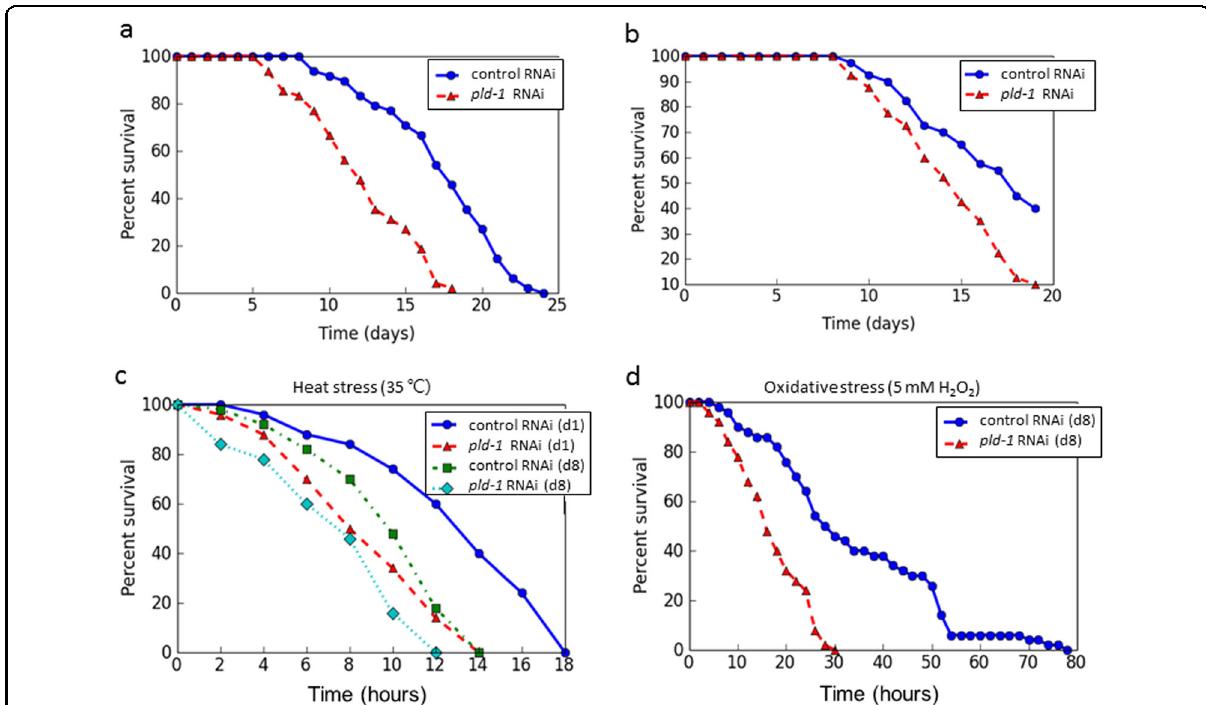
Fig. 2 Pld-1 RNAi decreases lifespan and stress resistance in nematodes. a , b Effect of pld-1 RNAi on the lifespan of nematodes. a Age- synchronized L4 larvae were fed on control RNAi or pld-1 RNAi plates under standard conditions ( n = 50 per condition). b Lifespan assays using nematodes fed with pld-1 RNAi only during adulthood to exclude the effect of pld-1 knockdown on development. Age-synchronized L4 larvae were fed on control RNAi or pld-1 RNAi plates for 1 day ( n = 50 per condition). c , d Effect of pld-1 RNAi on stress resistance in nematodes. c Survival curves of nematodes fed with control or pld-1 RNAi at 35 °C. Nematodes at day 1 (d1) or 8 (d8) of adulthood were scored every 2 h for viability ( n = 50 per condition). d Survival curves of nematodes fed with control or pld-1 RNAi after exposure to 5 mM H 2 O 2 for 5 h. Nematodes at day 8 (d8) of adulthood were scored every 4 h for viability ( n = 50 per condition). Viability was scored as movement away from pick touch at the indicated days or hours. Representative data from three independent RNAi experiments are